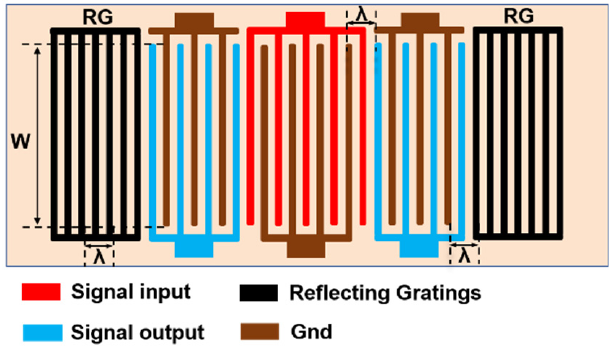
Figure 2. IDT design of the LCRF used in this study.